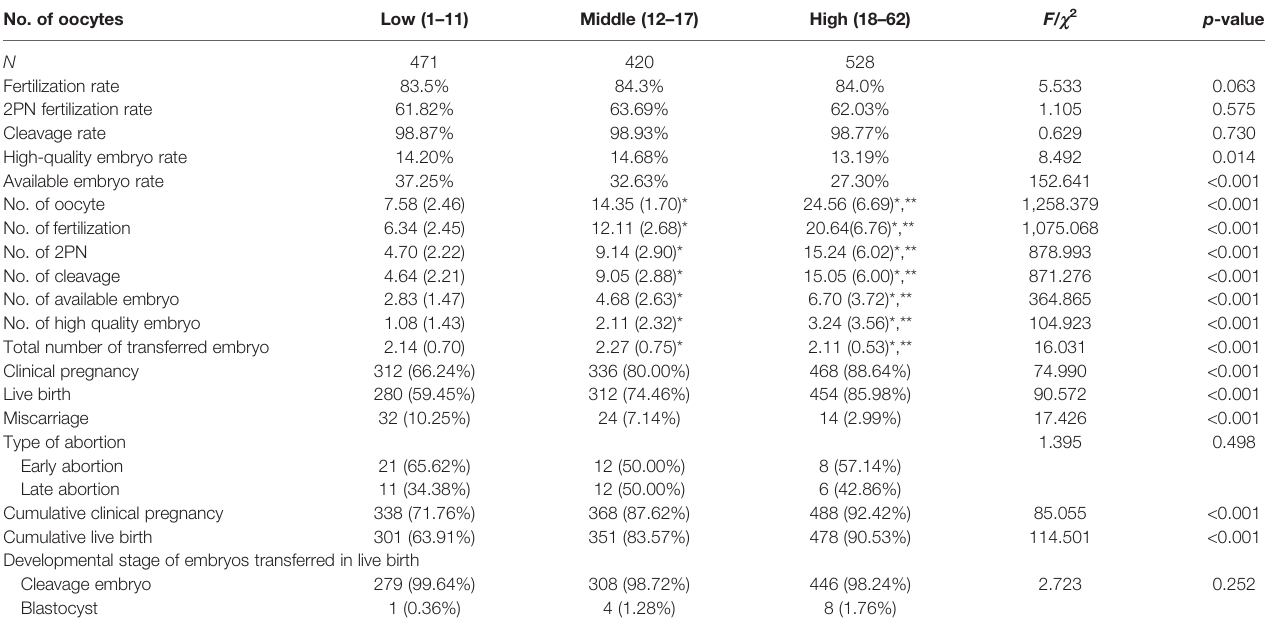
TABLE 2 | Patient ’ s laboratory indicators and clinical outcome.